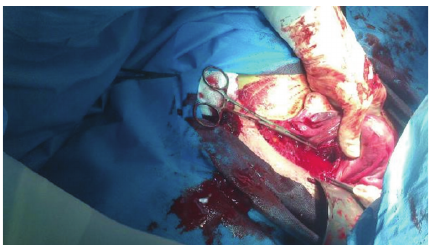
Figure 3: Uterus was evacuated and uterine defect repaired in two